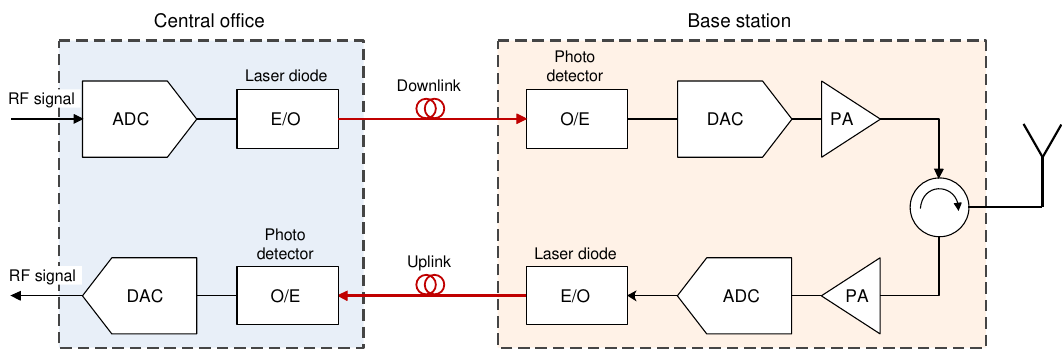
Figure 5. General A – RoF optical link architecture.